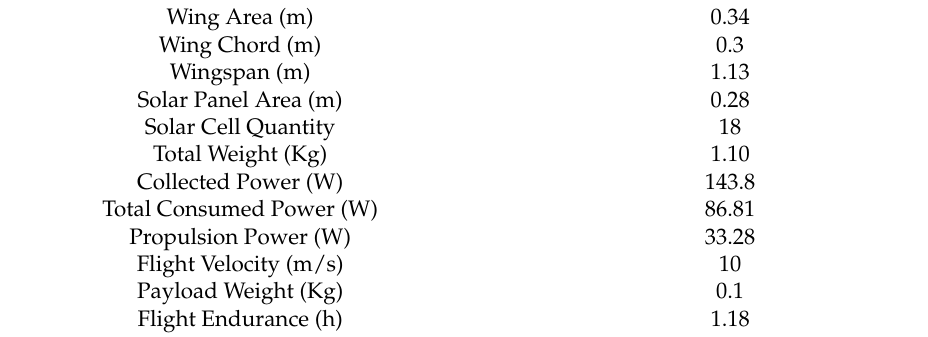
Figure 18. UAV Sizing results. Table 8. Aircraft output parameters.